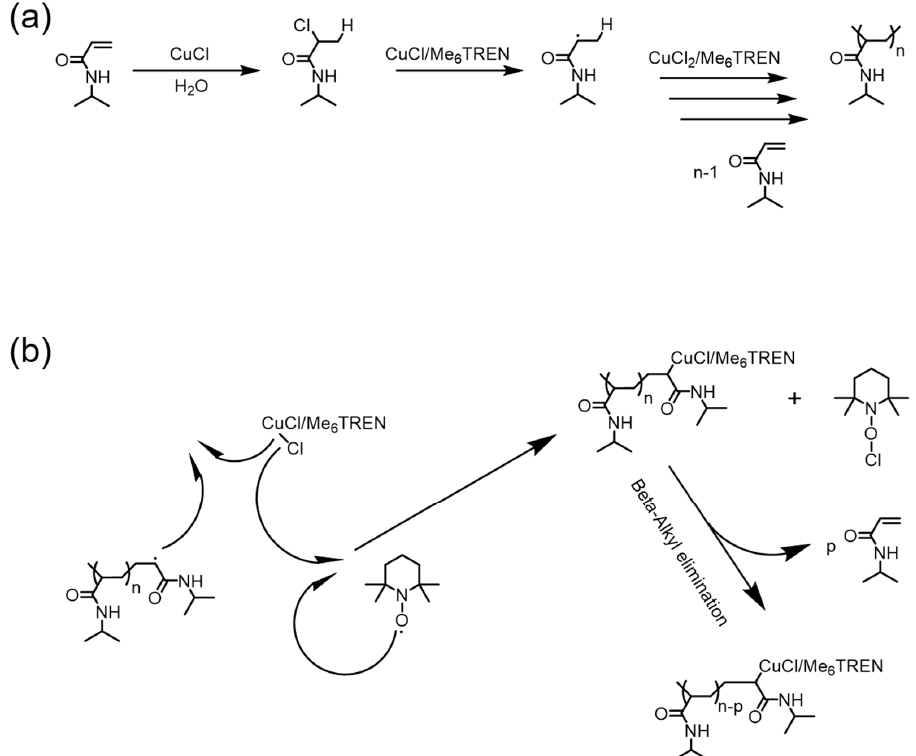
Figure 7. Reversible polymerization in copper-mediated polymerization systems. ( a ) Proposed mechanism of CuCl/ tris(2-dimethylaminoethyl)amine (Me 6 TREN)-based radical polymerization of N -isopropylacrylamide (NIPAM); ( b ) 2,2,6,6-tetramethylpiperidinooxy (TEMPO)-induced depolymerization mechanism via β-alkyl elimination. Reproduced with permission from [67].